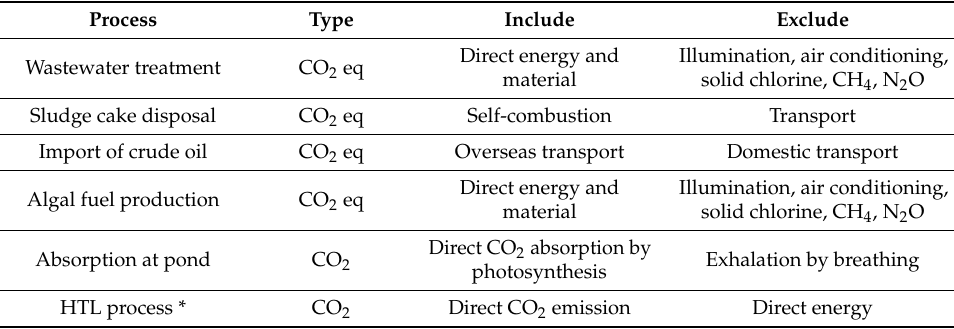
Table 11. Included and excluded matters in the calculation of GWP 100.